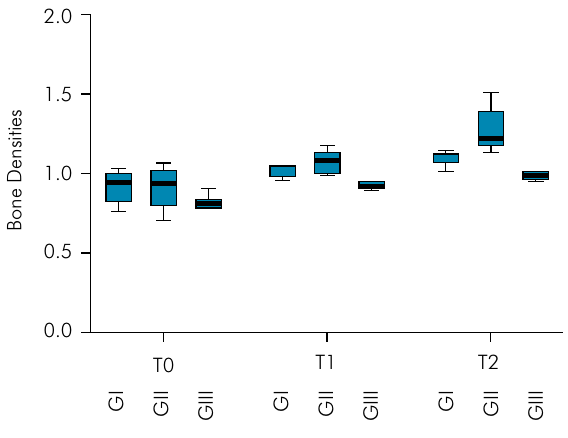
Figure 2. Boxplot of evaluation of measurements of bone densities obtained from radiographic of the subjects treated, between group, Scaling and Root Planning (SRP) + 10% DOX gel (GI), SRP + 10% DOX/ β -cyclodextrin gel (GII) and SRP (GIII), at T0 (initial RX), T1 (RX 60 days after T0) and T2 (RX 18 months after T0).